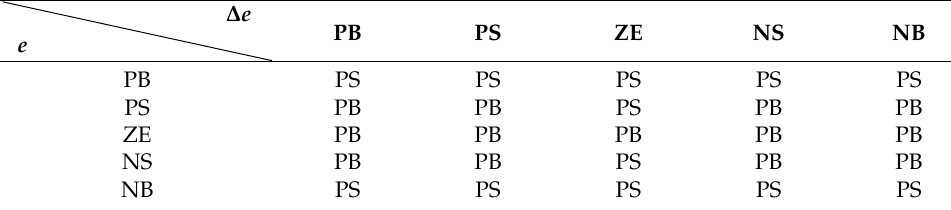
Table 3. Fuzzy rules of K d .